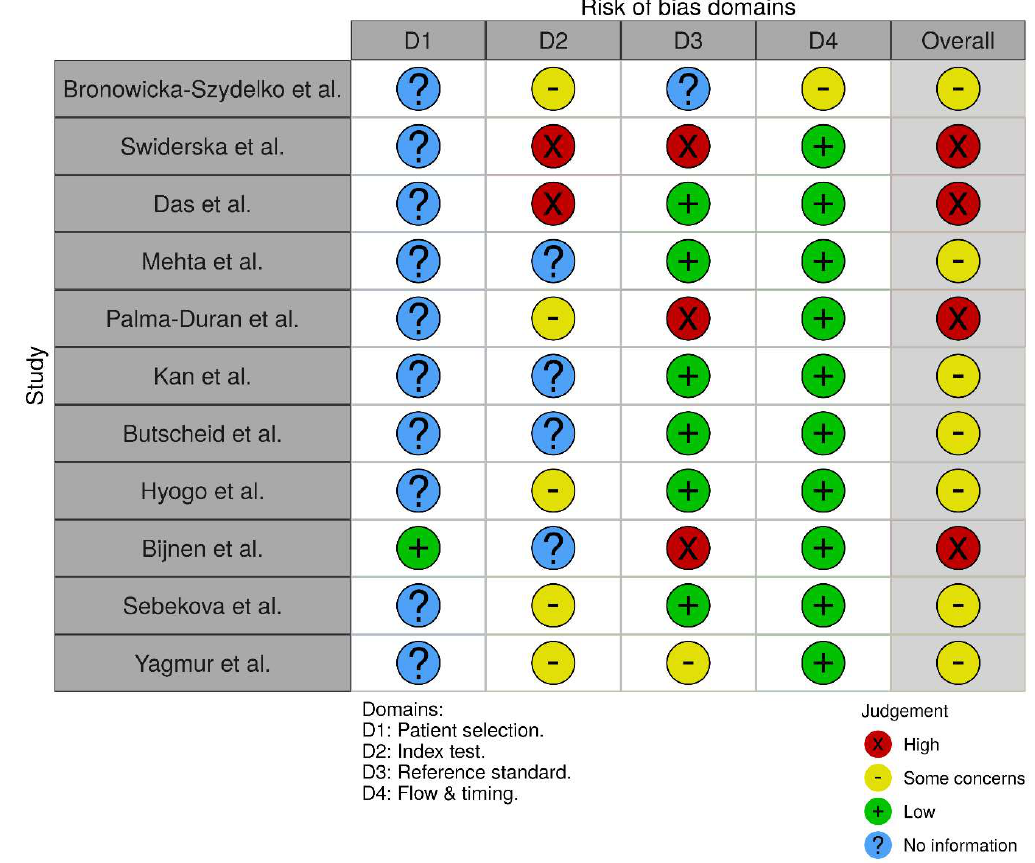
Figure 2. Risk of bias assessment [29–39]. Table 1. Characteristics of the included studies.